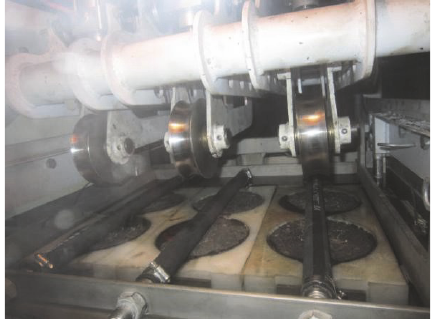
Figure 1: Cylinder specimens in APA